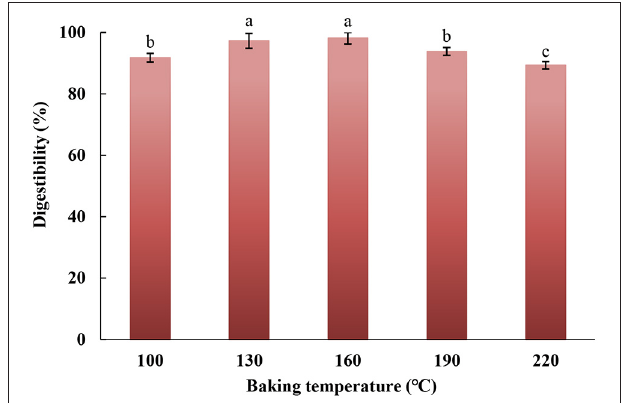
TABLE 3 | Sensory evaluation of eel burgers baked at various temperatures. Baking temperature ( ◦ C)